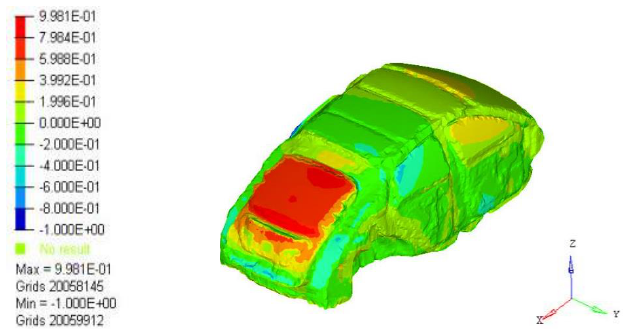
Figure 12. A 35 Hz cloud graph of plate joint contribution.